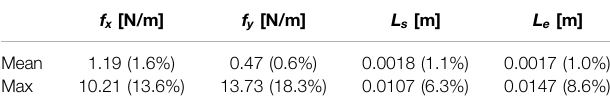
TABLE 3 | Simulation distributed force estimation errors over